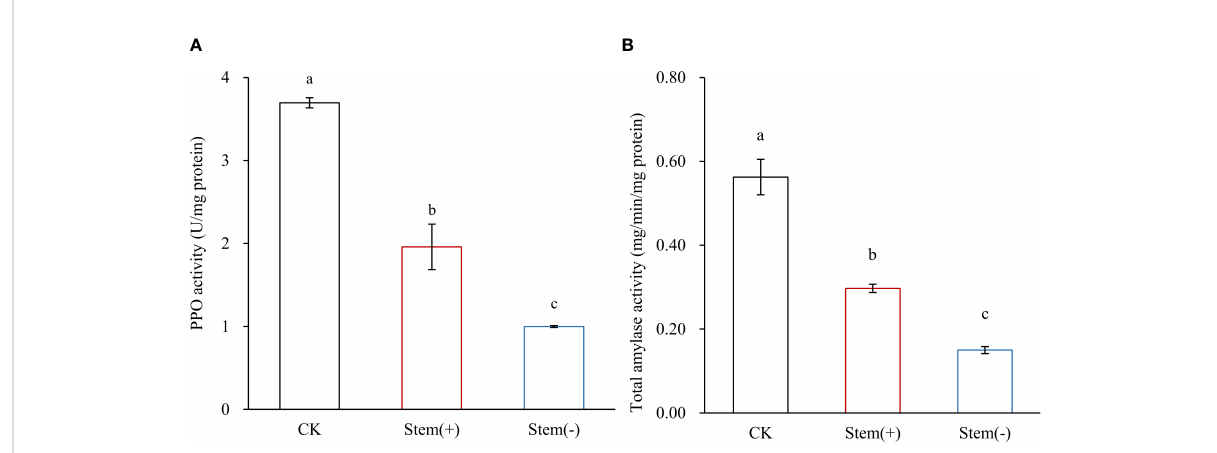
FIGURE 5 Effect of stem on PPO activity and total amylase activity in fl ue-cured tobacco leaves. Different letters indicate statistically signi fi cant difference at p < 0.05, as determined by